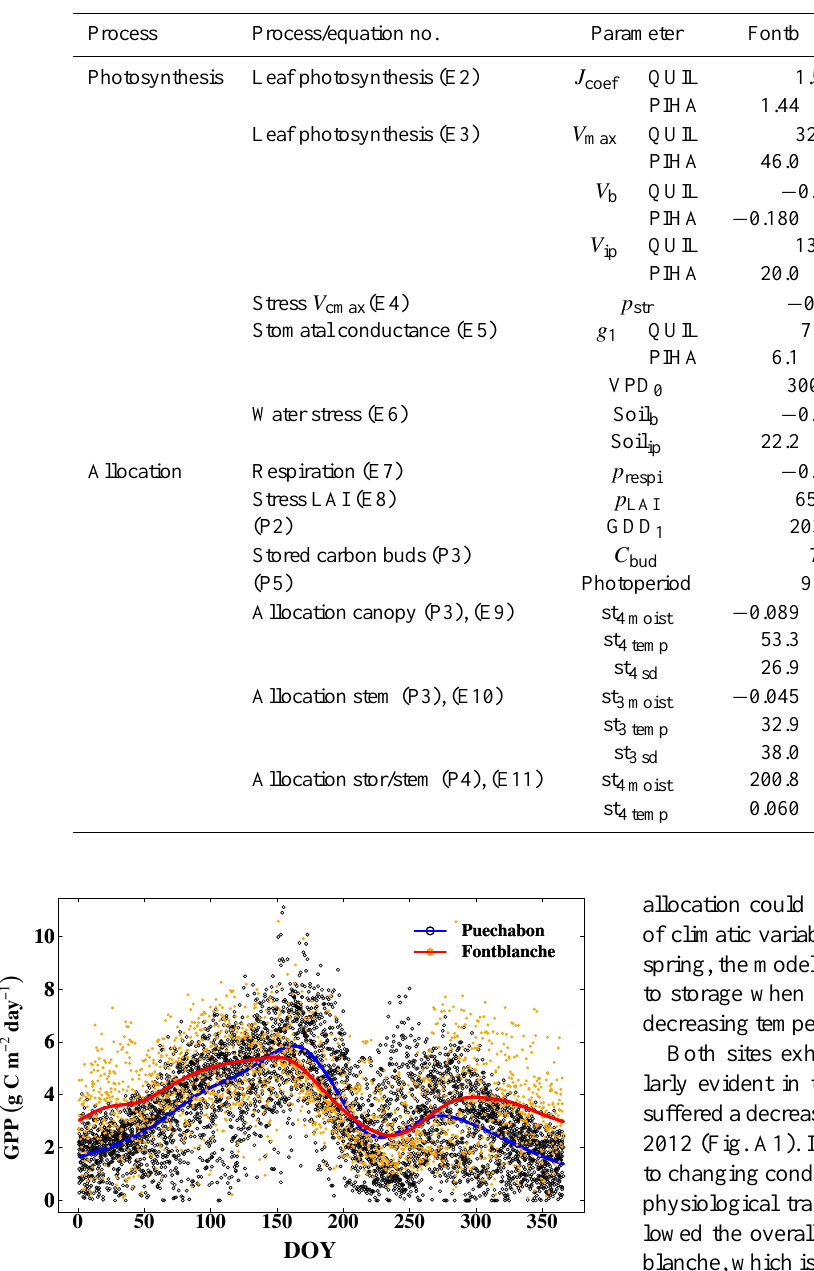
Table 2. Model parameters. Those parameter differing between sites were optimized either with GPP data (photosynthesis and allocation module) or with growth-based biomass increment chronologies (allocation module). The rest were common parameters for both sites and selected while developing the model in the first step for Fontblanche using GPP data (represented in the “Cal” column by “–”). Meaning of parameters, equation number (E) and phenophase (P) are as in the Material and Methods section. Fontb: Fontblanche; Puech: Puechabon;